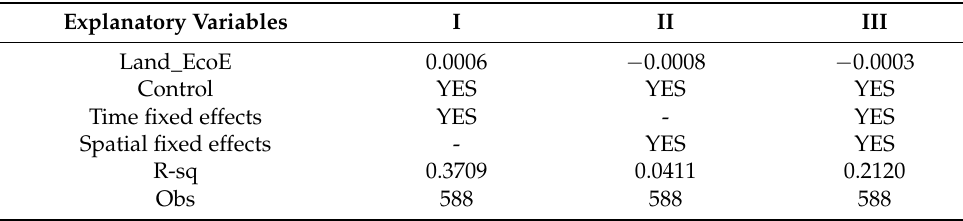
Table 3. Regression results for the spatio-temporal fixed effects of land economic efficiency *. Explanatory Variables